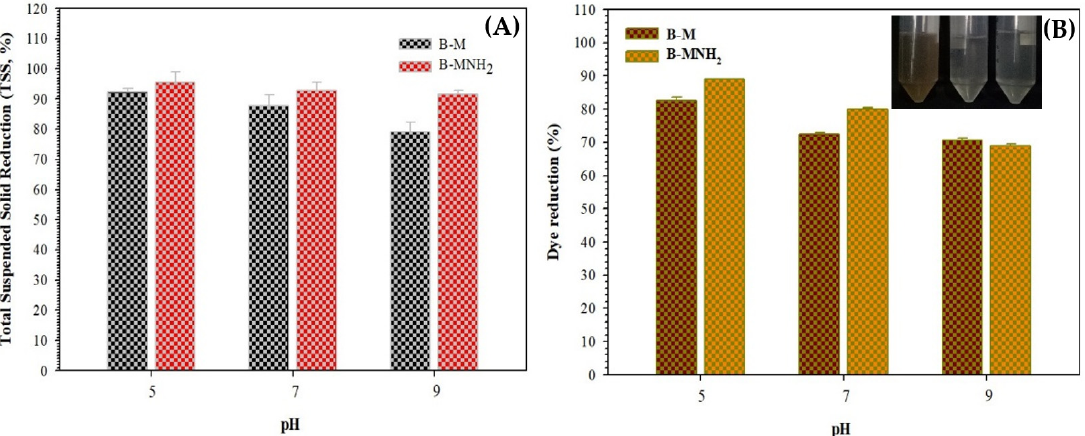
Figure 8. ( A ) TSS reduction and ( B ) dye reduction at different pH in the adsorption process with a sample volume of 300 mL, an initial Pb(II) ion concentration of 100 mg L − 1 , an adsorbent mass of 60 mg, and a stirring speed of 150 rpm for 360 min.